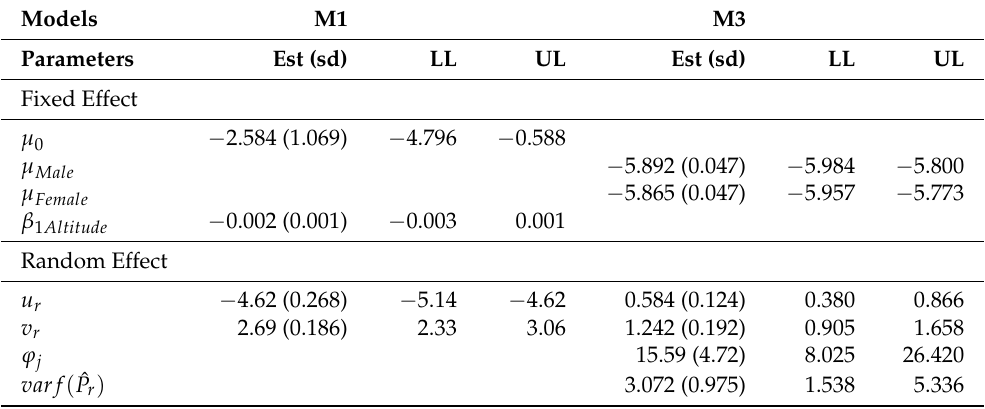
Table 2. Malaria risk parameter estimates for M1 and M3.